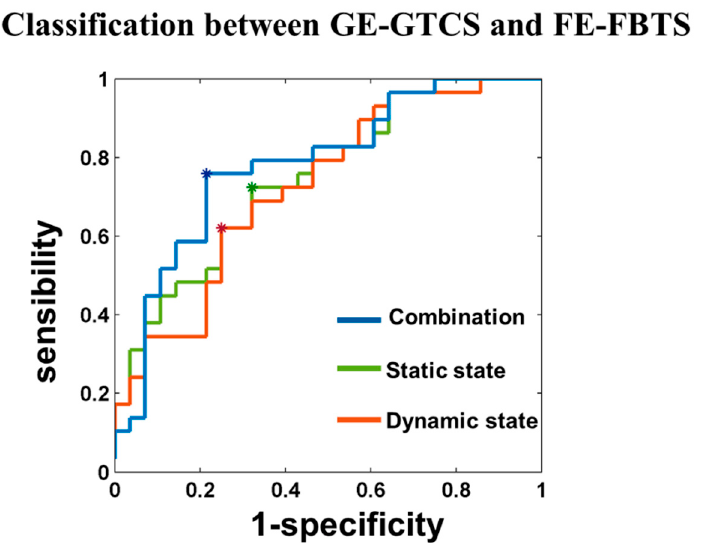
Figure 4. Classification between GE-GTCS and FE-FBTS. The accuracy, sensitivity, specificity, and AUC values between GE-GTCS and FE-GTCS were 66.67%, 72.74%, 67.86%, and 0.7475 when using static measures (Green); 68.42%, 62.07%, 75.00%, and 0.7278 when using dynamic measures (Orange); and 77.19%, 75.86%, 78.57%, and 0.7833 when combining static and dynamic functional connectivity metrics